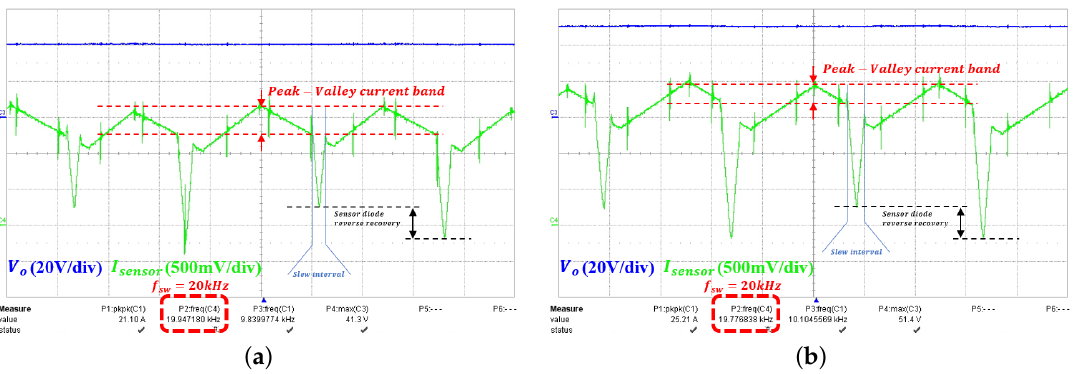
Figure 21. Experimental current and voltage waveforms of the proposed HCMC: ( a ) V o = 40 V; ( b ) V o = 50 V; ( V o = 20 V/div, I sensor = 500